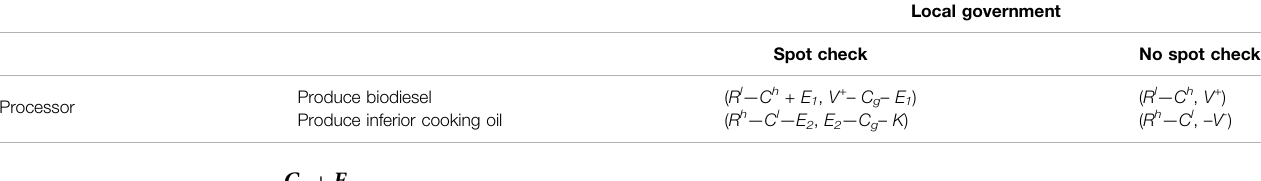
TABLE 2 | Spot check performed before the subsidy is